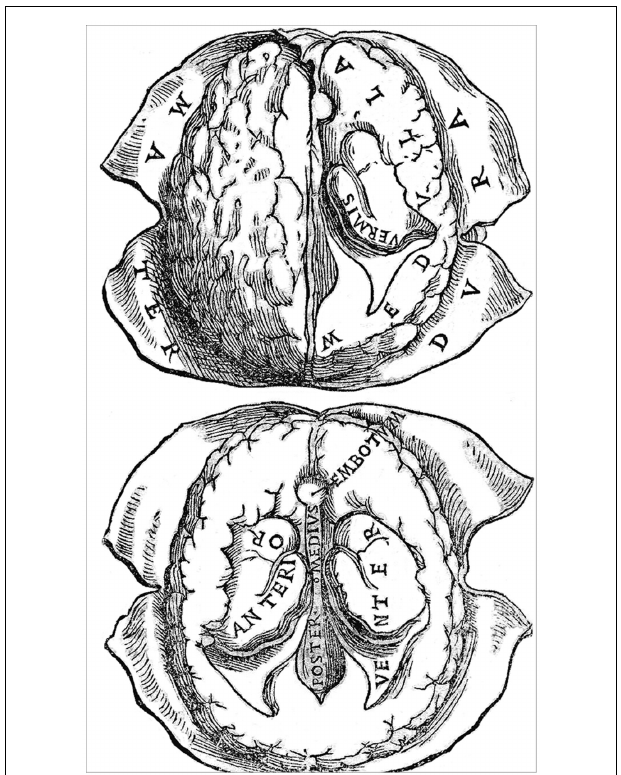
FIGURE 6 | A woodcut (folio 56r) from the Bologna 1523 edition of Berengarios’s Isagogae breves . It offers two fairly accurate horizontal views of the human brain drawn from nature, with emphasis on the organization of the meninges, particularly the dura mater, and the ventricular system. The top figure, which depicts the brain at a slightly more dorsal level than the bottom figure, shows the left hemisphere intact, with indications of sulci and gyri, whereas the right hemisphere has been dissected out so as to show the dorsal aspect of the lateral ventricle and its prominent vermis (choroid plexus). The bottom figure provides a more detailed view of the ventricular system on both sides of the brain. The anterior (lateral) ventricle is shown along its full anterior-posterior extent, with the middle (third) and posterior (fourth) ventricles depicted at a lower level. The middle ventricle is bordered anteriorly by the embotum (infundibulum and pituitary stalk). Courtesy of the National Library of